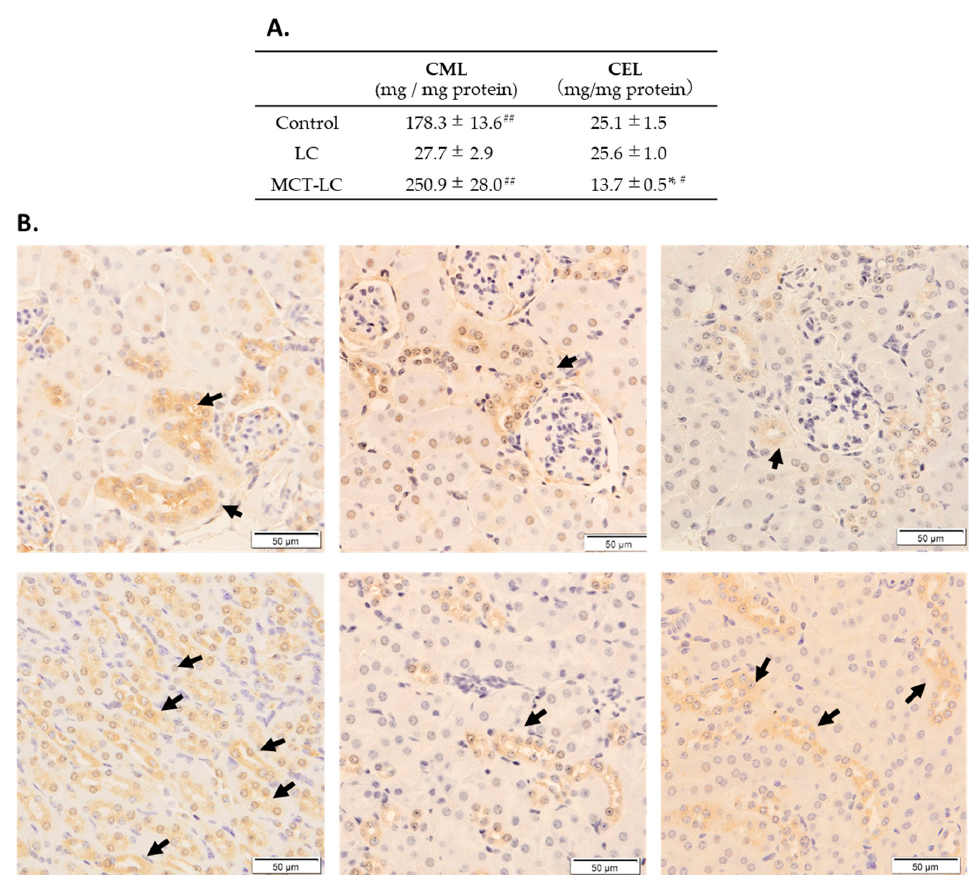
Figure 4. CML and CEL concentrations in kidney supernatant ( A ) and CML staining of the kidney ( B ), The first row ( B ) shows the renal cortex area where glomeruli gather, and the second row ( B ) shows medulla area where tubules gather. Data shown are mean ± SEM. Control, control diet; LC, low-carbohydrate diet high in lard; MCT-LC, low-carbohydrate diet high in medium-chain triglyceride. * p < 0.05, ** p < 0.01 vs. control, # p < 0.05, ## p < 0.01 vs. LC by the Tukey’s HSD test.